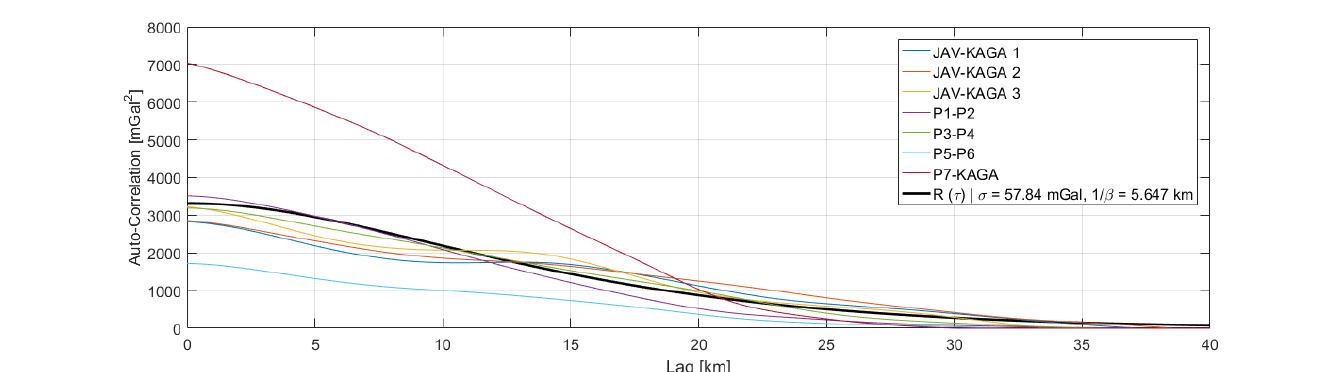
Figure 4. Estimated autocorrelation functions for the seven profiles along with the (least squares) best fitting third-order Gauss–Markov autocorrelation function. The parameters σ = 57.84 mGal and 1/ β = 5.647 km.